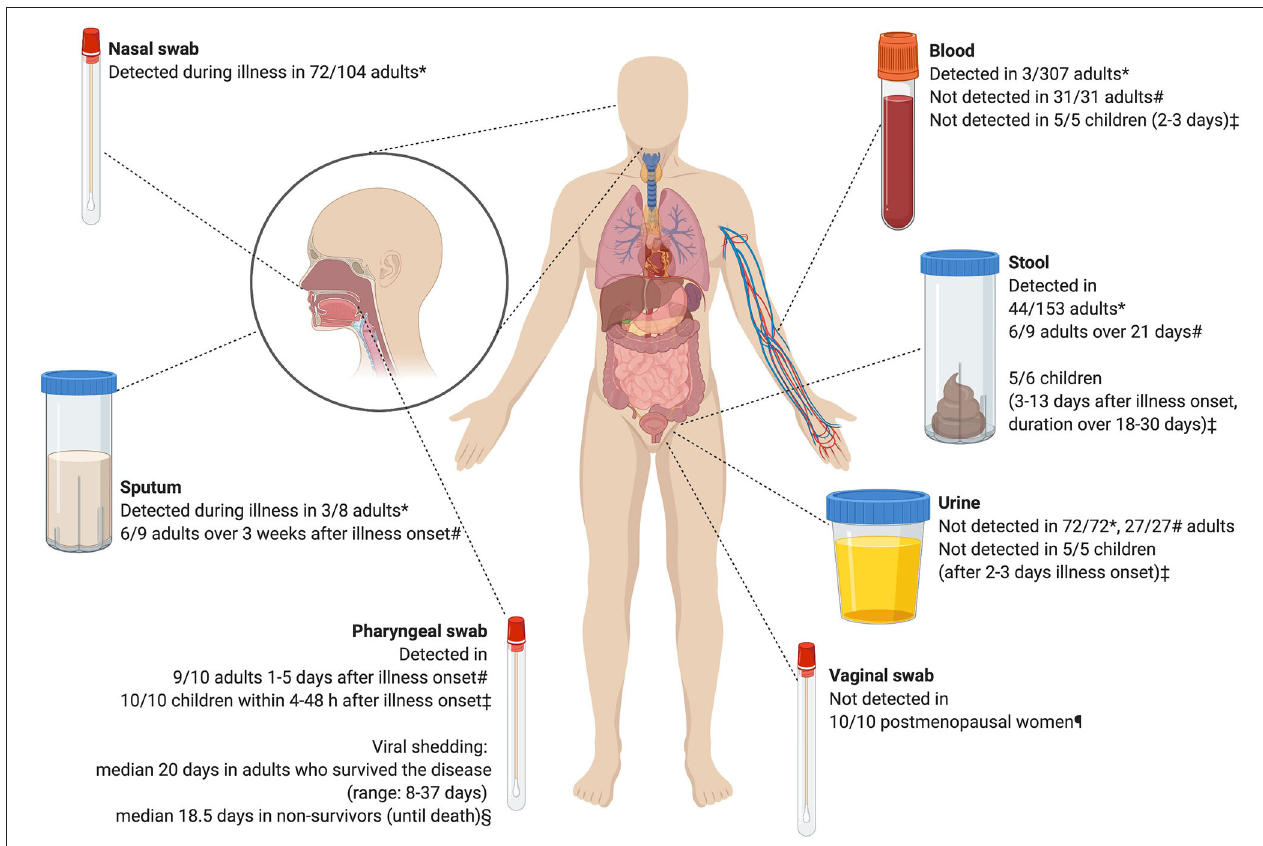
FIGURE 1 | Detection of severe acute respiratory syndrome coronavirus 2 (SARS-CoV-2) by polymerase chain reaction after illness onset. Based on * 11 , § 12 , ‡ 13 , # 14 , ¶ 15 . The figure was created with